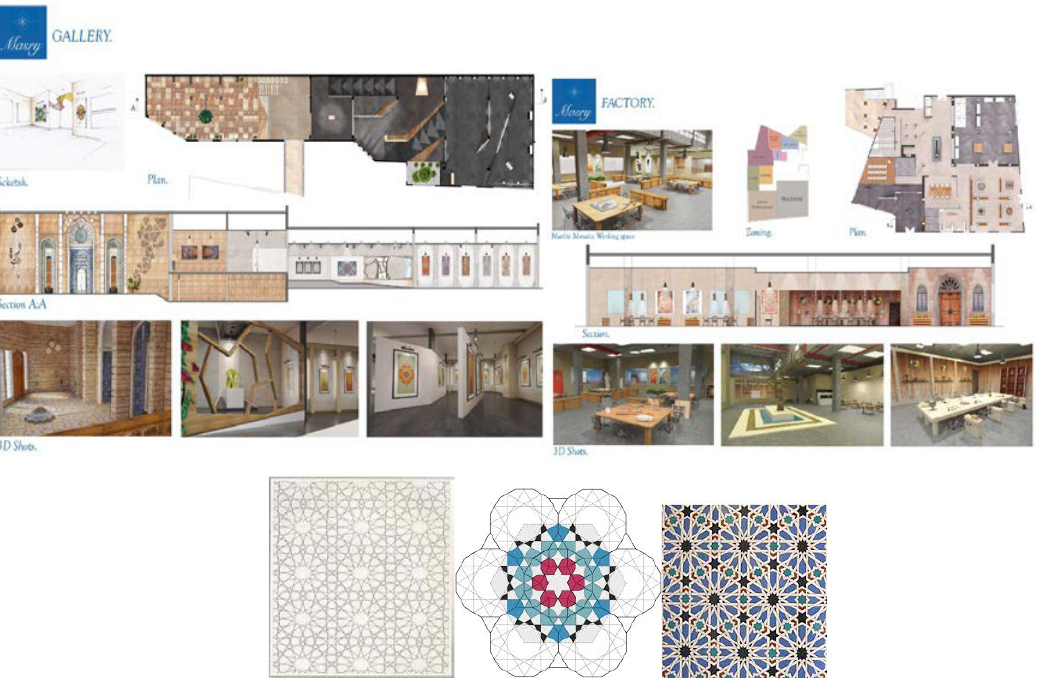
Figure (12): Different shots of Arts and Crafts Centre in El Fostat- Masr el Adima inspired by the Islamic geometrical shapes including workshops to get the best use of marble wasted pieces to reform and recycle them into decorative and functional furniture pieces. Source: Interior design Department digital archive library of Grad.